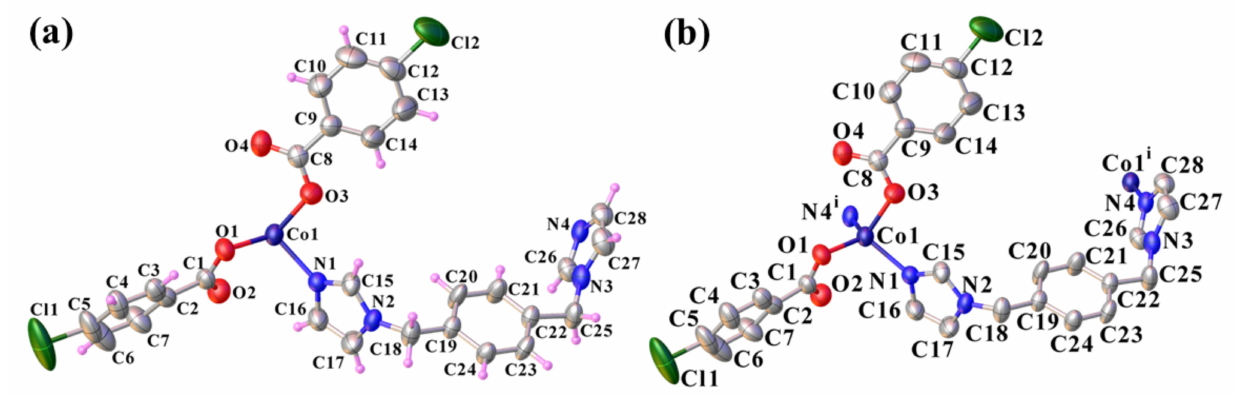
Figure 5. ( a ) The asymmetric unit of 2 . ( b ) The coordination environment for Co 2+ in 2 .